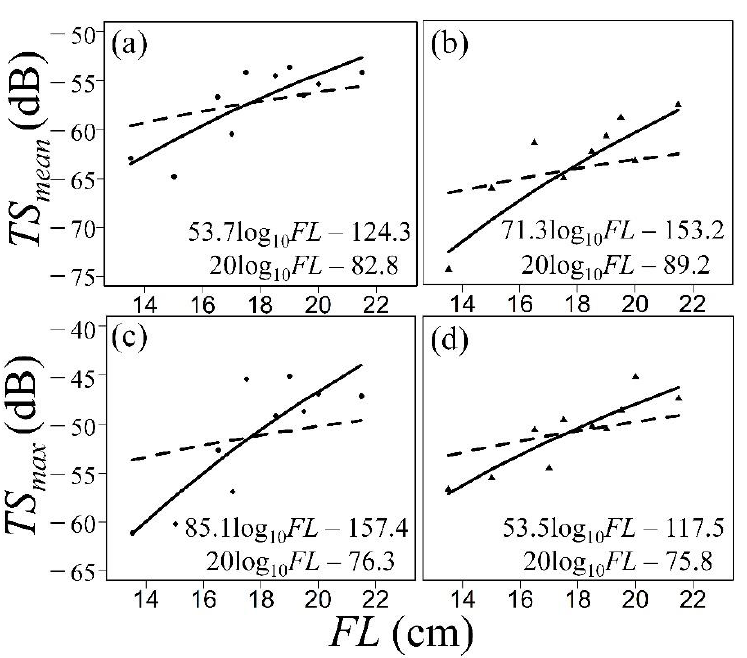
Figure 3. Relationship between fork length ( FL ) and estimated TS mean at 38 kHz ( a ), FL and estimated TS mean at 120 kHz ( b ), FL and estimated TS max at 38 kHz ( c ) and FL and estimated TS max at 120 kHz ( d ) in this study. The black line shows TS = a ∗ log FL + b , whereas the dotted line shows TS = 20 ∗ log FL + TS cm